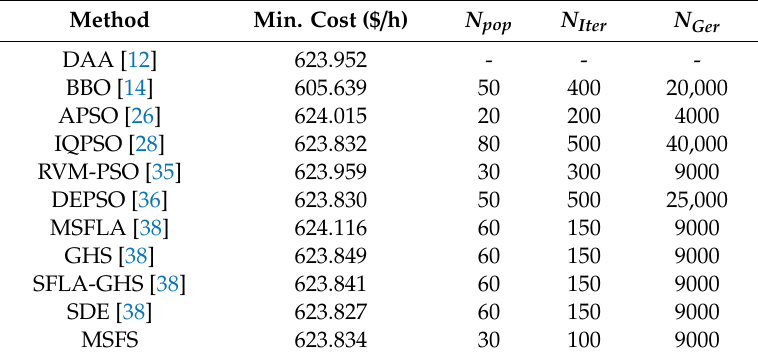
Table 10. Comparison of the implemented results for case 7.